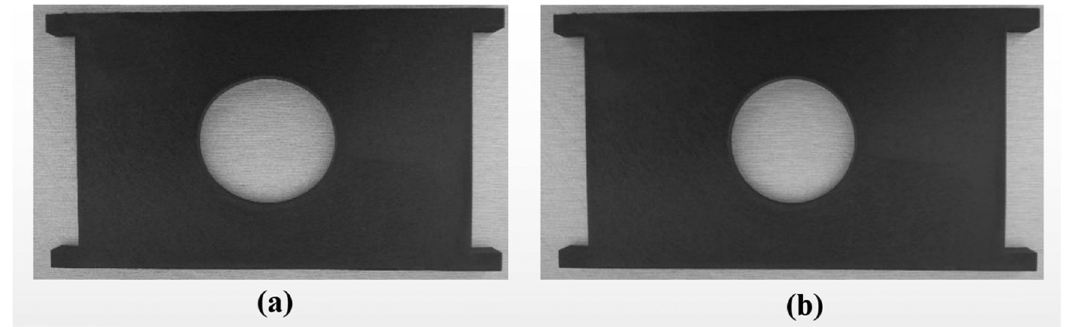
Figure 3: The shape of the central circular hole of the plate: ( a ) without the “ supporting mold ” and ( b ) with the “ supporting mold. ”